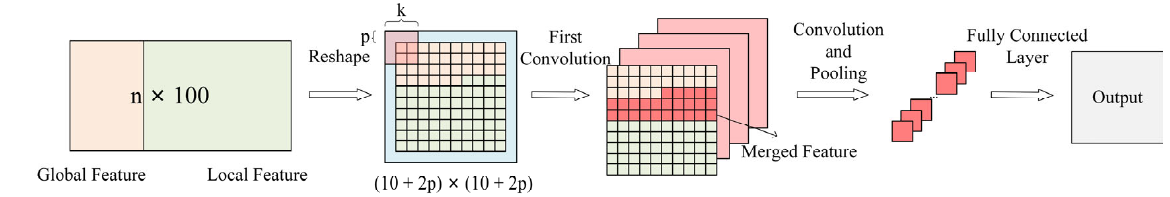
Figure 6. Feature combination process in FinalNet.